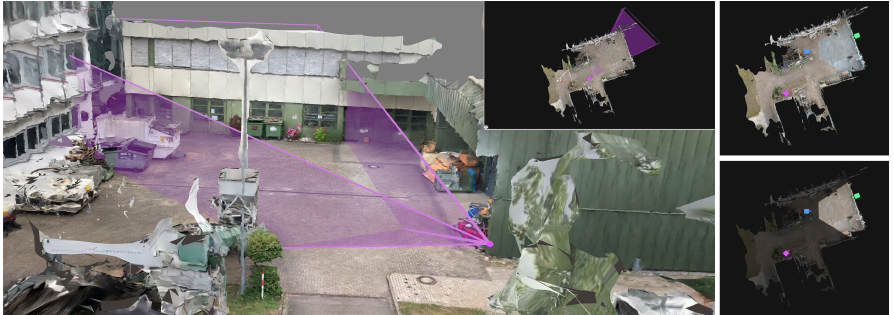
Figure 18. The camera frustums displayed in the scene and minimap can be customized: either as semi-transparent objects ( Left ) or using additive ( top right ) or subtractive ( bottom right ) lighting.